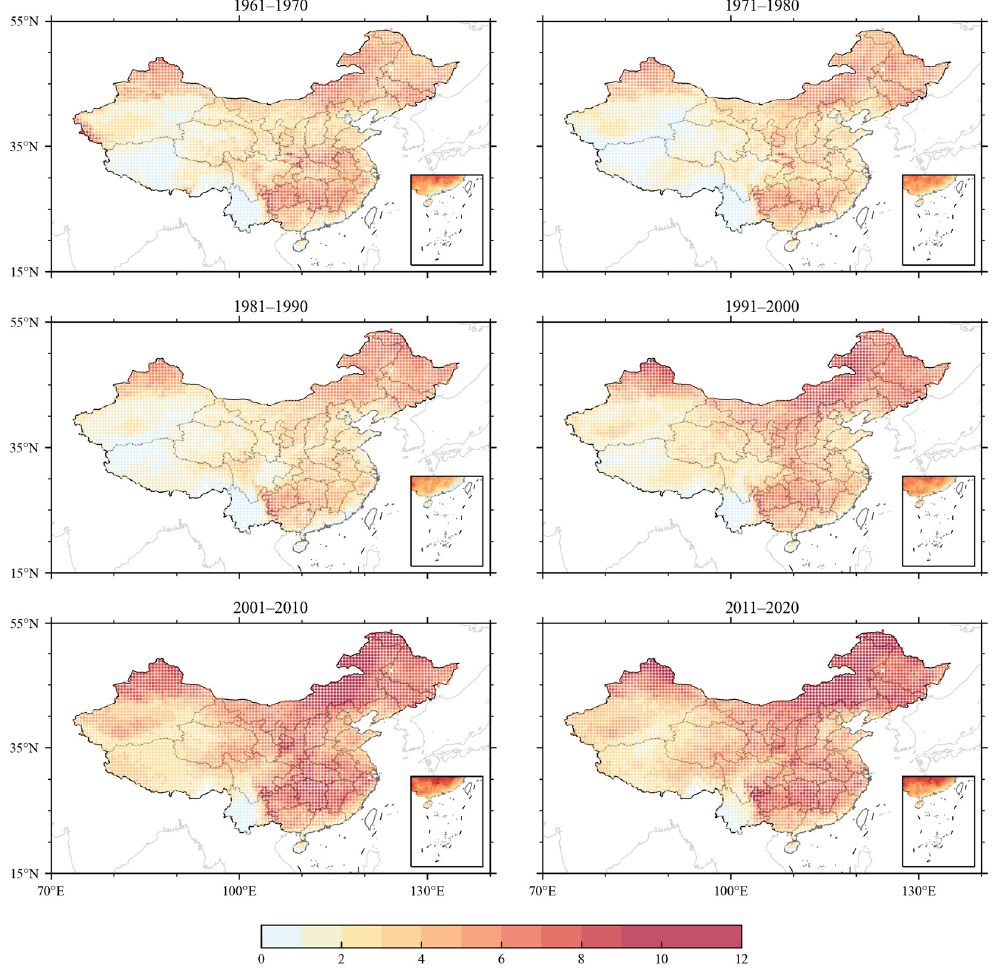
Figure 9. Distribution diagram of the decadal average frequency of heat waves based on FATM.